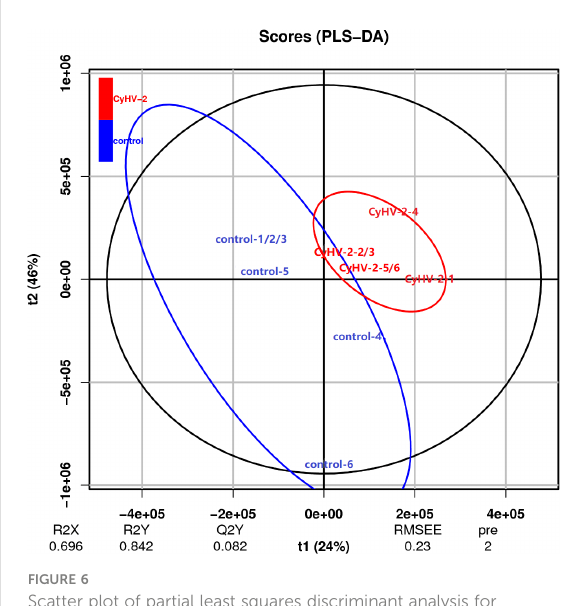
FIGURE 6 Scatter plot of partial least squares discriminant analysis for metabolite pro fi les from control and CyHV-2-infection groups. Each group was conducted in six replicates and named control- 1/2/3/4/5/6 and CyHV-2-1/2/3/4/5/6. The distance of each point represents their